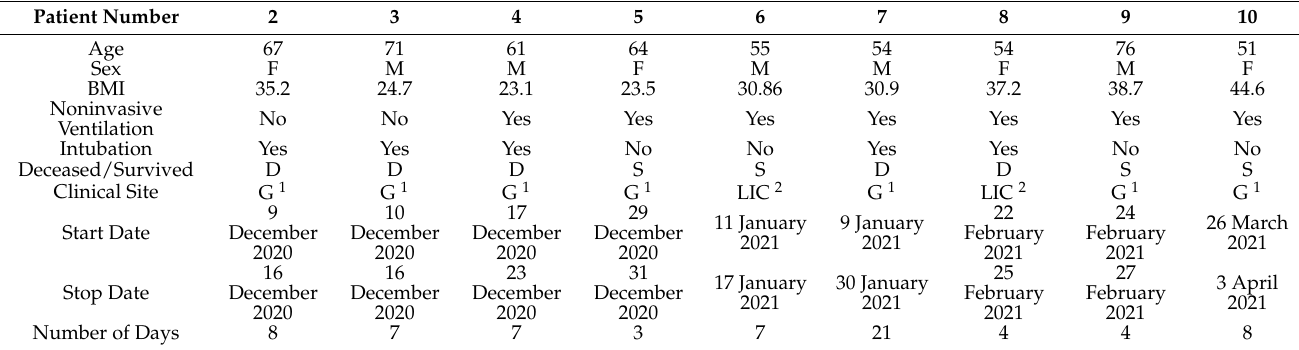
Table 2. Information about the